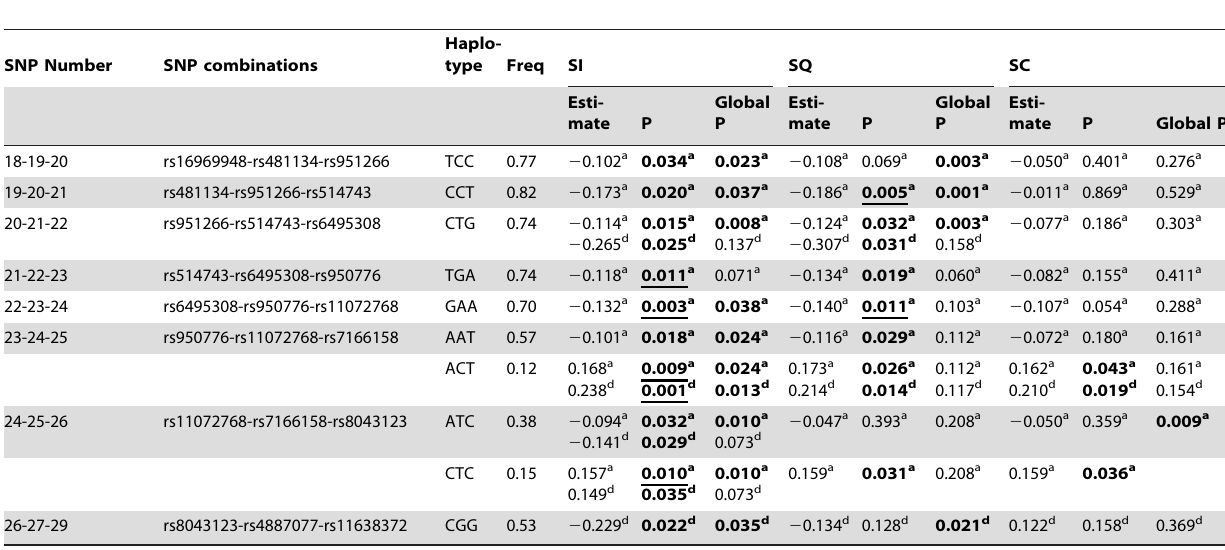
Table 4 . Statistics estimates and P values for major haplotypes showing significant associations at the 0.05 level with at least one smoking-related phenotype under the additive and dominant models in the male sample.